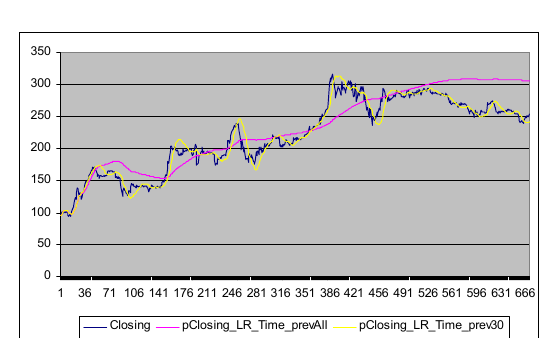
Figure 7: Company SLR